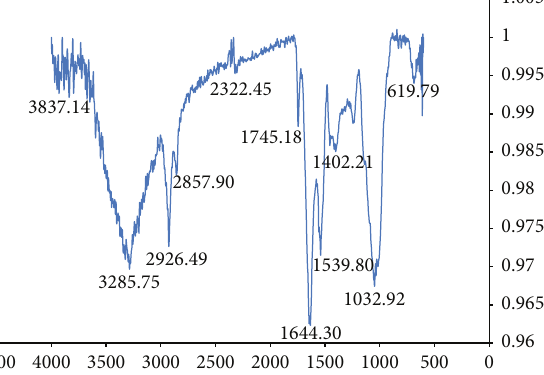
Figure 3: Analysis of C. fistula seeds utilizing